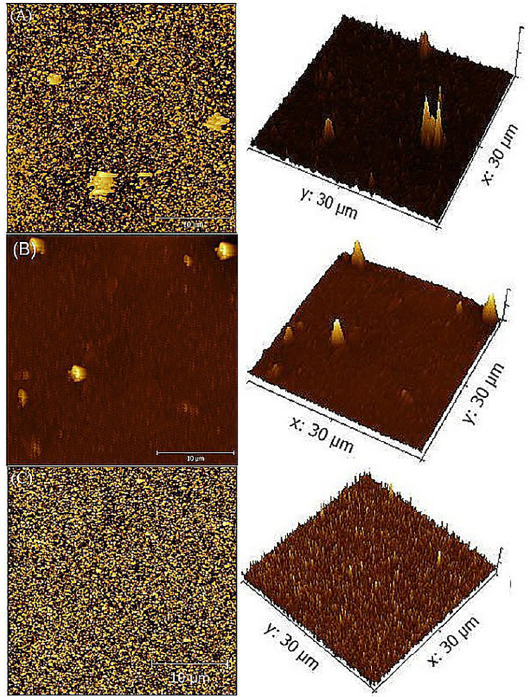
Figure 4. Morphological images of the surface of the films studied with different thicknesses.